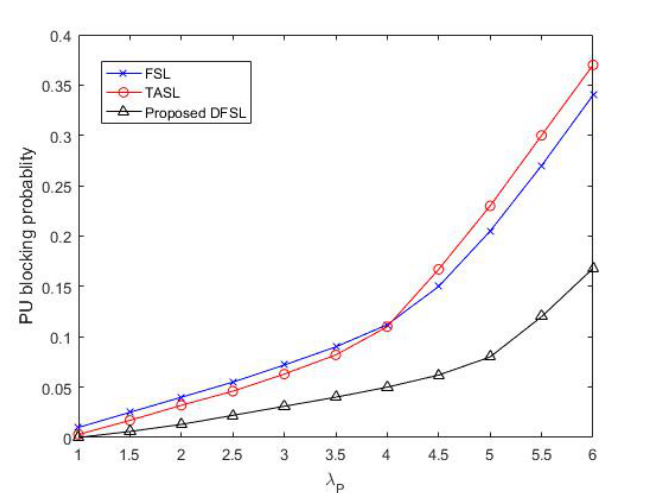
Figure 11. PU blocking probability versus λ P .